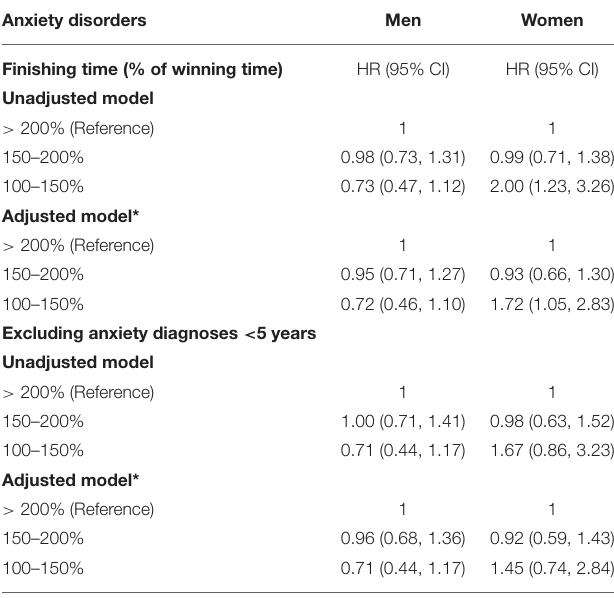
TABLE 3 | Association between ski race finishing time and incident anxiety disorders in men and women. Anxiety disorders Men